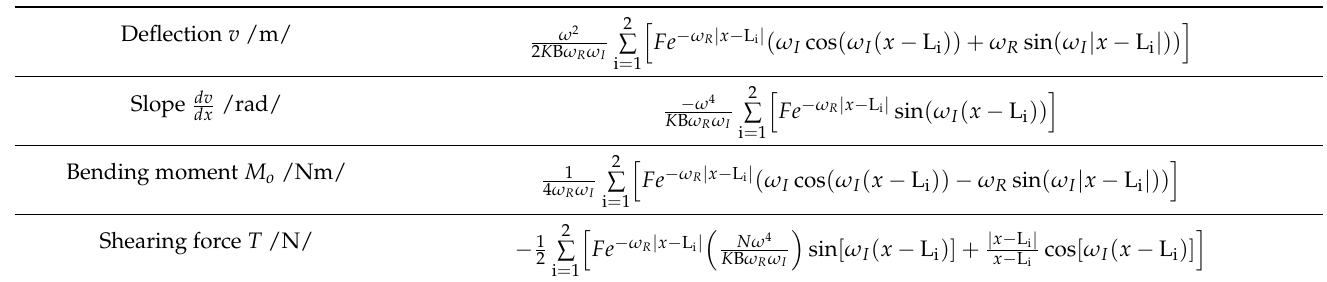
Table 2. Particular solution of a beam on an elastic foundation loaded by two point forces, F and a tensile force N , for x ∈ (cid:104) 0; ∞ ) and Figure 7.